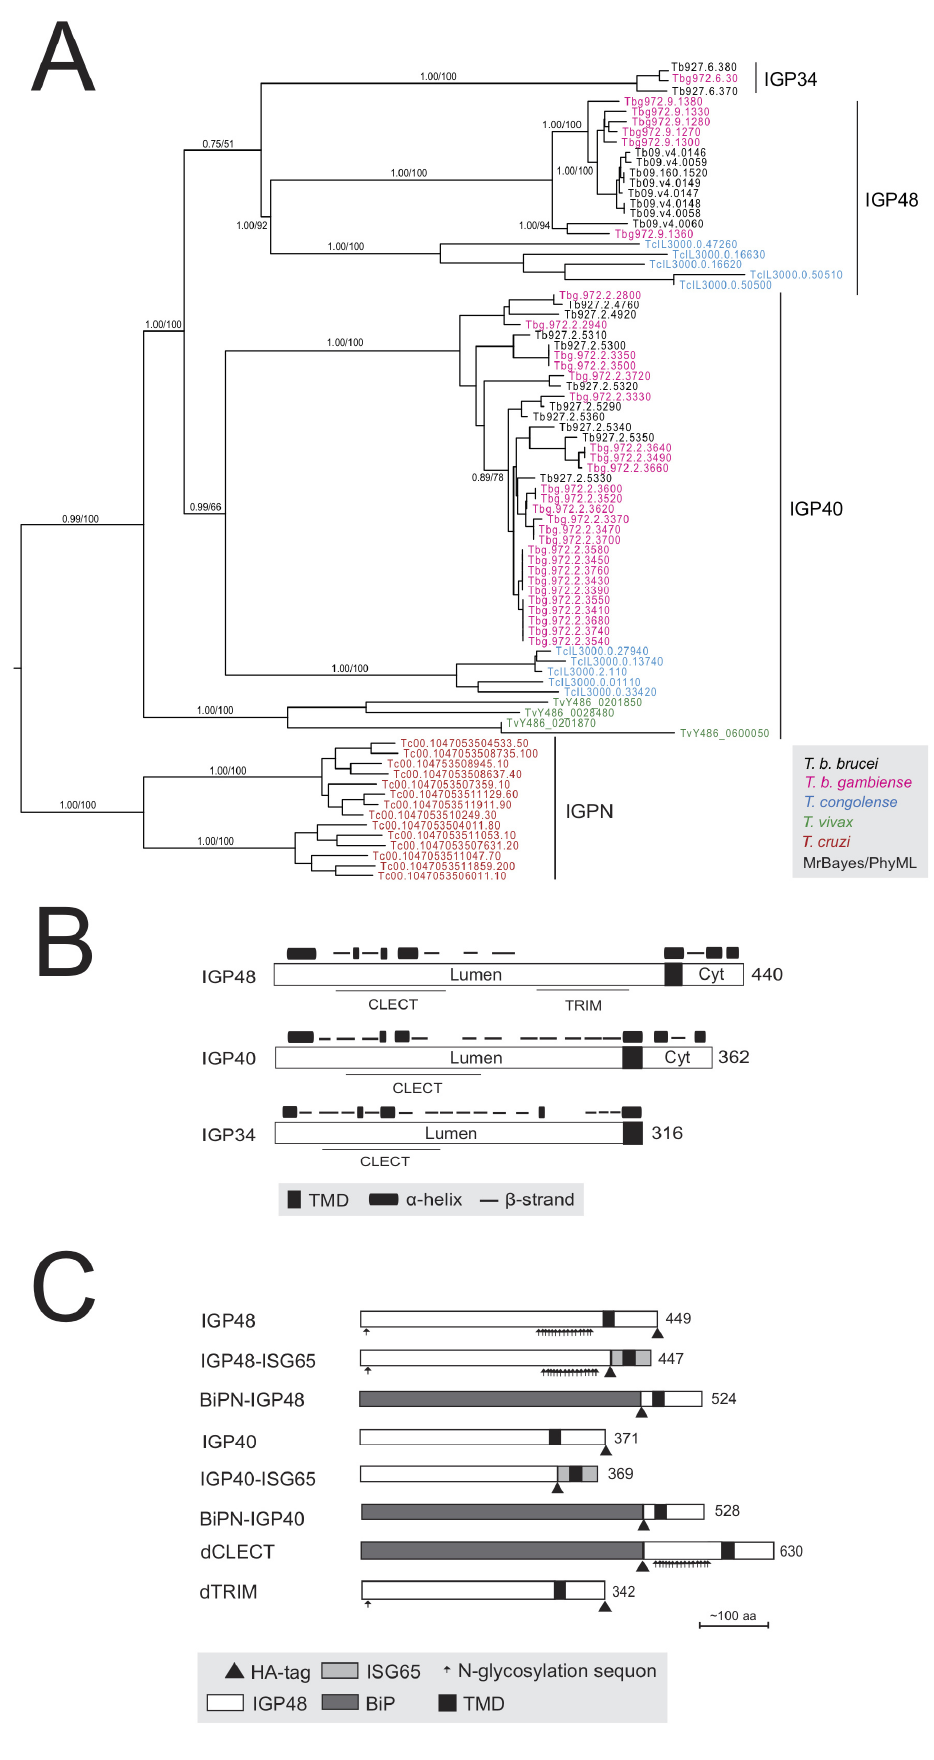
FIGURE 1: The invariant glycoprotein (IGP) family. (A) Phylogenetic reconstruc- tion of the IGP family. The tree shown is the best Bayesian topology with branch support for im- portant nodes indicated from both Bayesian and PhyML calculations. Clades are indicated by vertical bars. (B) Schematic diagram showing the secondary structure prediction and domain architecture of the IGP family. Lumen indicates the portion of the molecule predicted to be within the